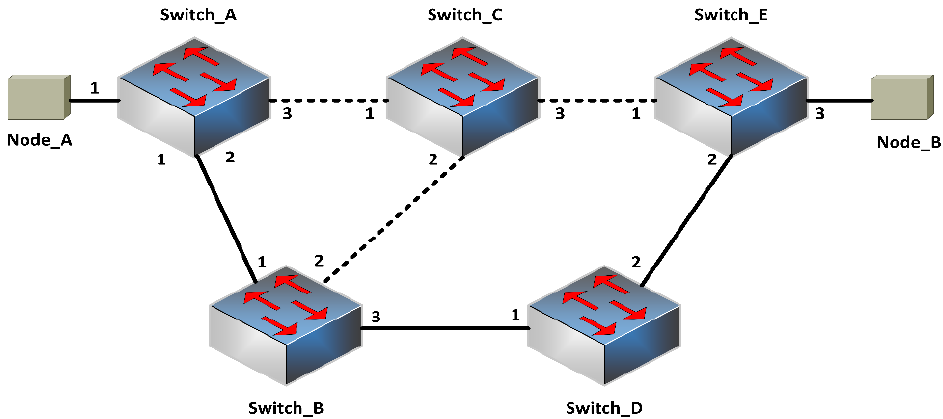
Figure 5. OpenFlow based source routing.